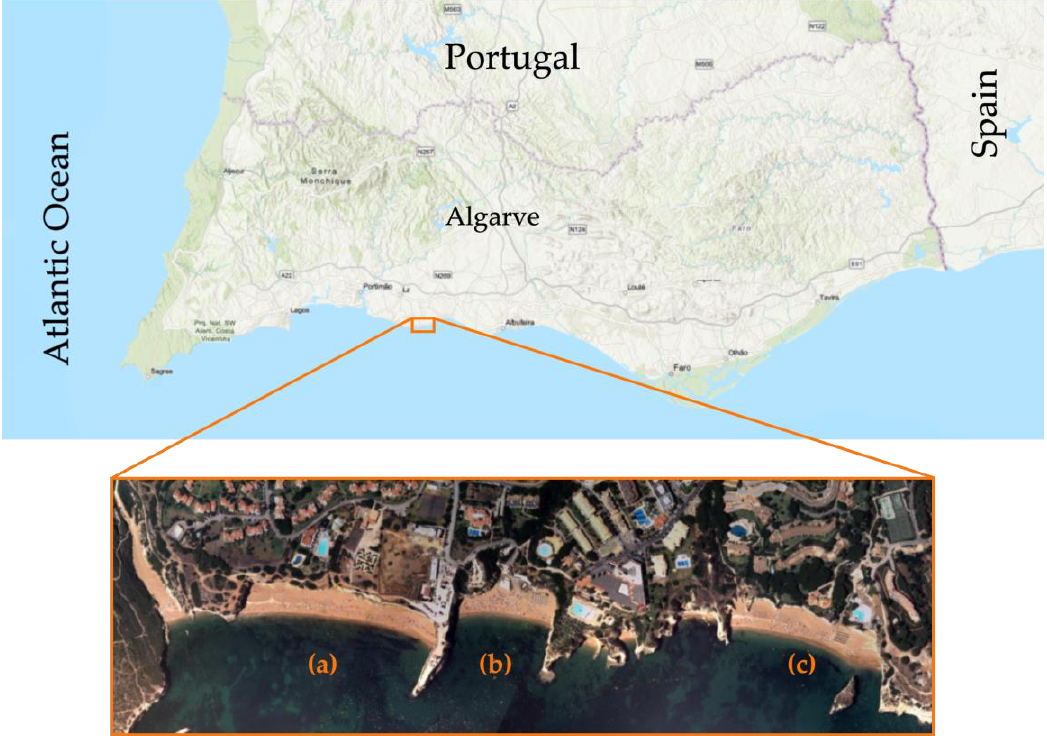
Figure 3. Location of the area in study: ( a ) Praia Nova, ( b ) Praia dos Pescadores and ( c ) Praia da Cova Redonda.